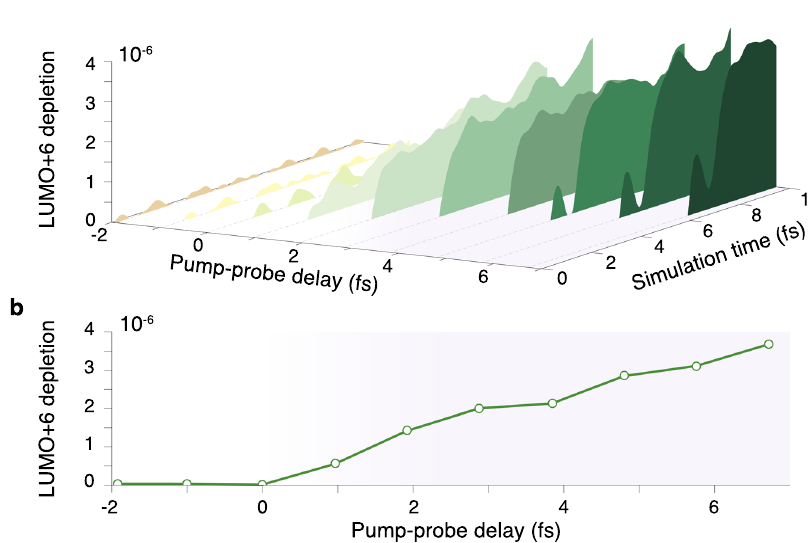
Fig. 4 Role of the NIR probe pulse. a Temporal evolution of the LUMO + 6 state depletion due to the combined action of XUV and NIR pulses as a function of the delay. b Simpli fi ed readout with the state depletion averaged in a 1 fs window after the NIR pulse. The signal is absent at zero delay although half the NIR pulse then exposes the sample after the centre of the XUV pulse, it then shows a signi fi cant onset in the window of 2 – 4 fs and keeps increasing with larger delays. The trend reported in b reproduces, remarkably, the one of the time-dependent yield measured for the adenine dication. These results have been obtained with the non-equilibrium Green ’ s function